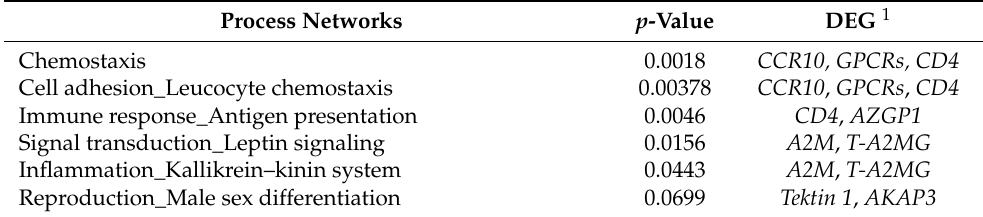
Table 5. Process Networks identified by MetaCore software ( p -value < 0.10) from the list of differ- entially expressed genes (FDR 10%) in the skeletal muscle of pigs fed with two different levels of soybean oil in the diet.